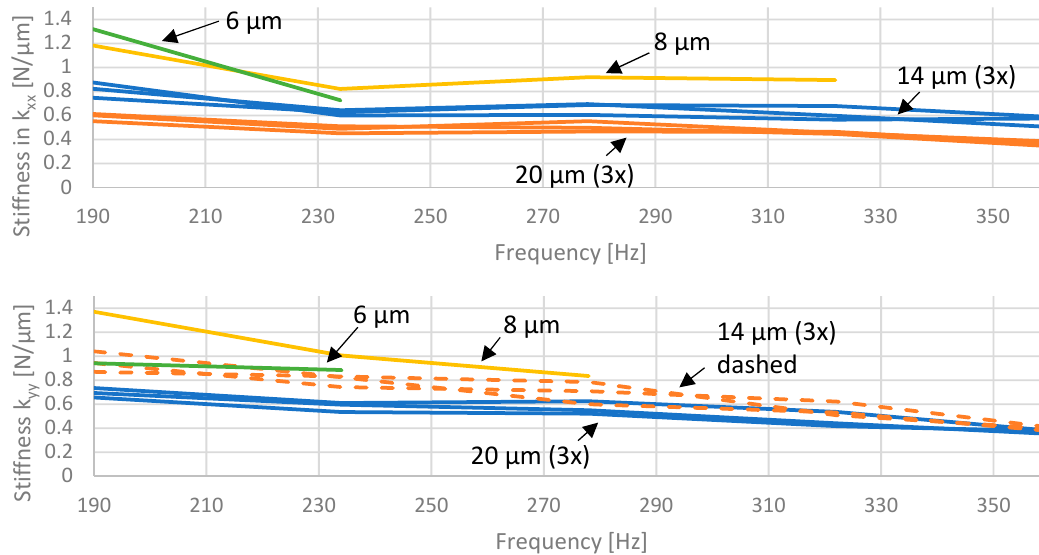
Figure 13. Influence of different displacement amplitudes on direct stiffness coefficients at 11.1 N static load; tests with 6 µ m and 8 µ m were stopped due to poor control behavior (highly non-linear); repeated measurements (3 times) including new controlling sequences (see error discussion of controller).